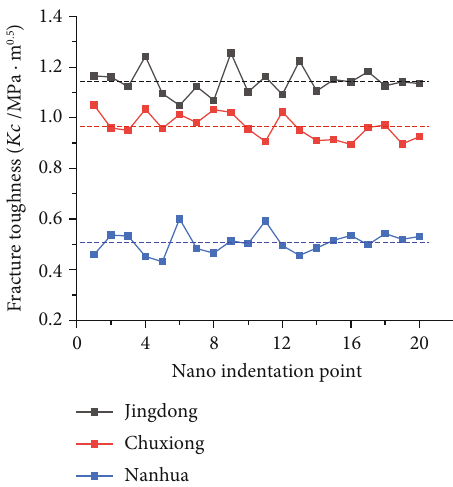
Figure 15: Fracture toughness distribution of Yunnan red-bed mudstone in three